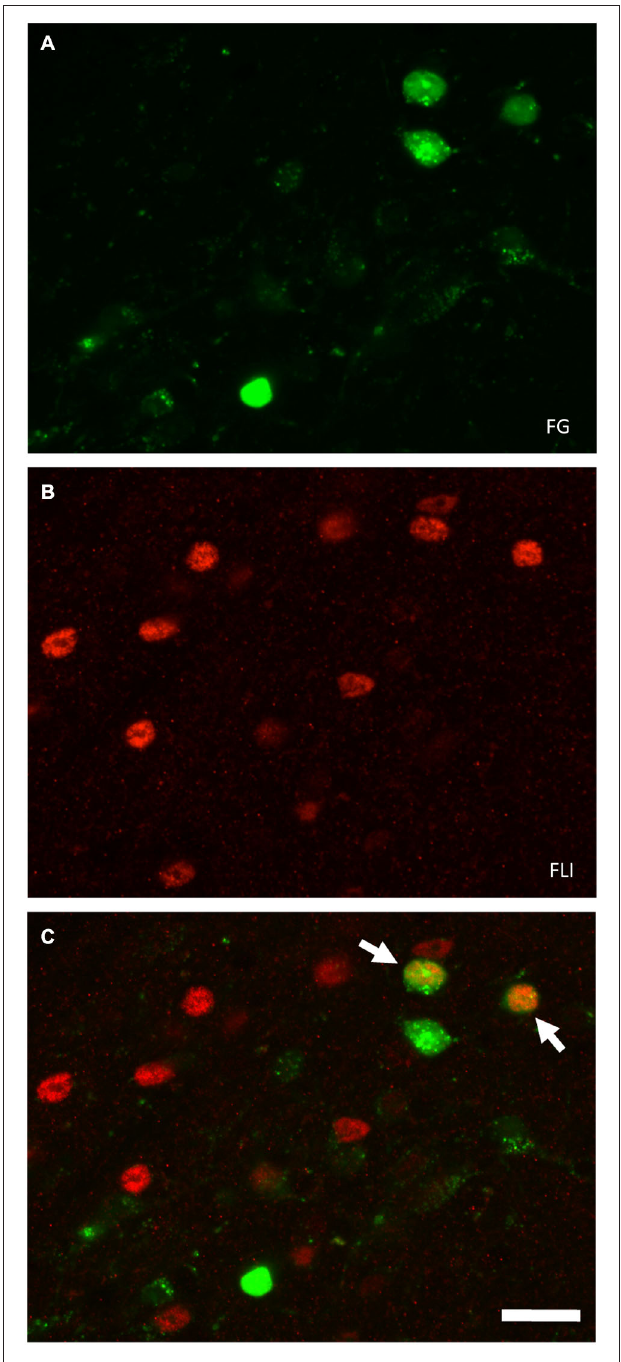
FIGURE 2 | Fluorescent images of double-labeled and single-labeled neurons in the ipsilateral PbN (dl subnucleus) following LH injections of FG . Images were captured using a confocal microscope (Zeiss 710, Carl Zeiss MicroImagining, Inc., Thornwood, NY, USA). (A) FG-labeled cell somata. (B) FLI-positive nuclei. (C) In the merged image, there are two examples of double-labeled cells (arrows). Scale bar = 20 µ m.